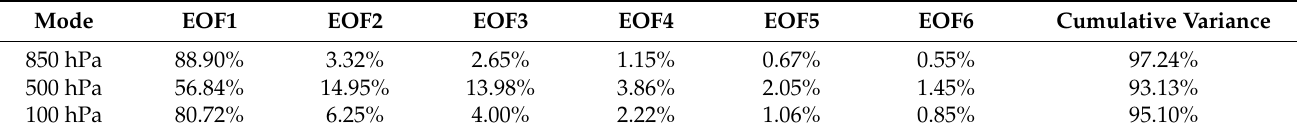
Table 4. Variance contribution and cumulative variance of the first six modes of EOF analysis of CO concentration in different pressure layers of the global troposphere.